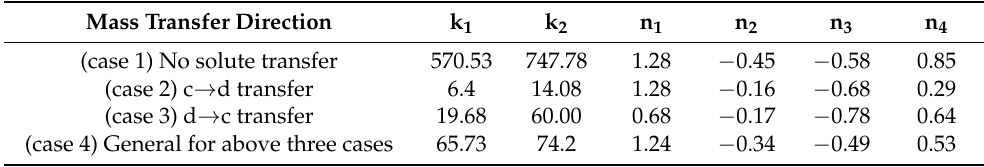
Table 1. Values of dispersed phase (DP) holdup of Kumar and Hartland correlation under various mass transfer